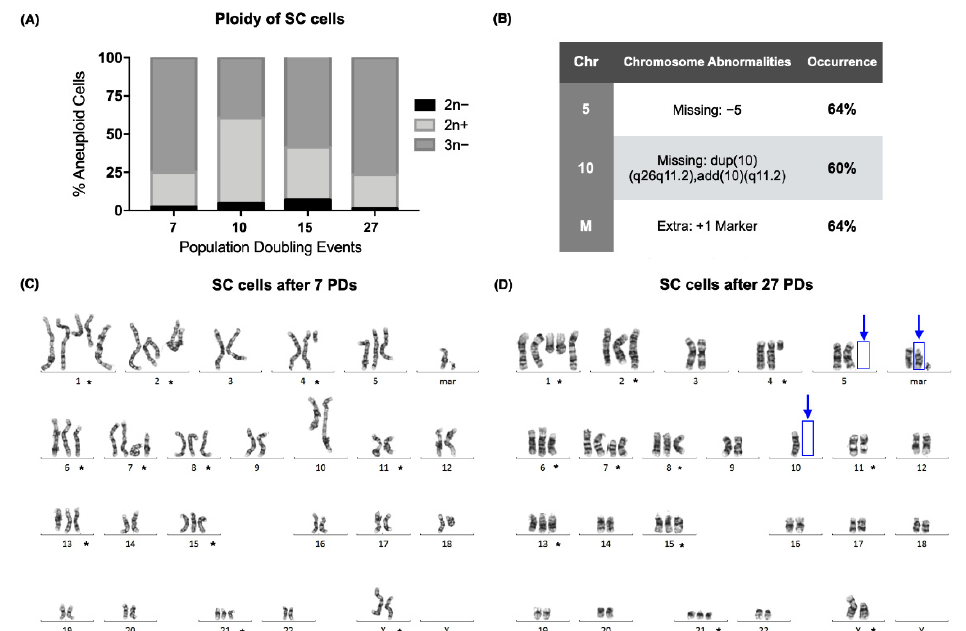
Figure 1. A hypotriploid clone of the SC cells was established, but numerical chromosomal instability was still present. ( A ) Percentage of aneuploid cells after 7, 10, 15, and 27 population-doubling events (PDs) of the SC cell line. Over 50% of the analyzed cells were hypotriploid (3n − ) in 3 of the sampled PDs. ( B ) Table with the chromosomal abnormalities found after 27 PDs of the SC cell line. Approximately 60% of the analyzed cells displayed a loss of chromosome 5 and of a derivative chromosome 10, together with the appearance of an extra chromosome marker. ( C ) Karyogram of the SC cells after 7 population-doubling events. The numerical or structural chromosomal alterations that were found in every sampled population are marked (*). ( D ) Karyogram of the SC cells after 27 population-doubling events. The numerical or structural chromosomal alterations that were found in every sampled population are marked (*). Additional chromosomal abnormalities are marked with blue arrows.